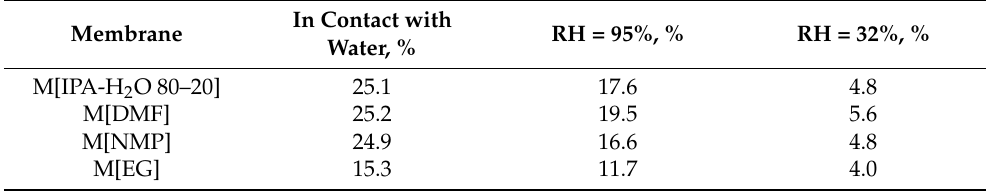
Table 3. Water uptake (wt.%) of the studied membranes in H + -form at different relative humidity. In Contact with Membrane RH = 95%, Water, %